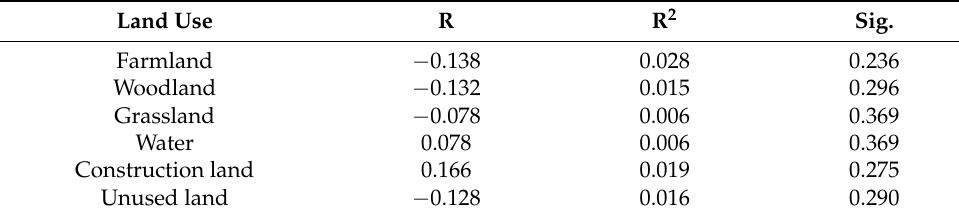
Table 9. Correlation analysis results for land use and water